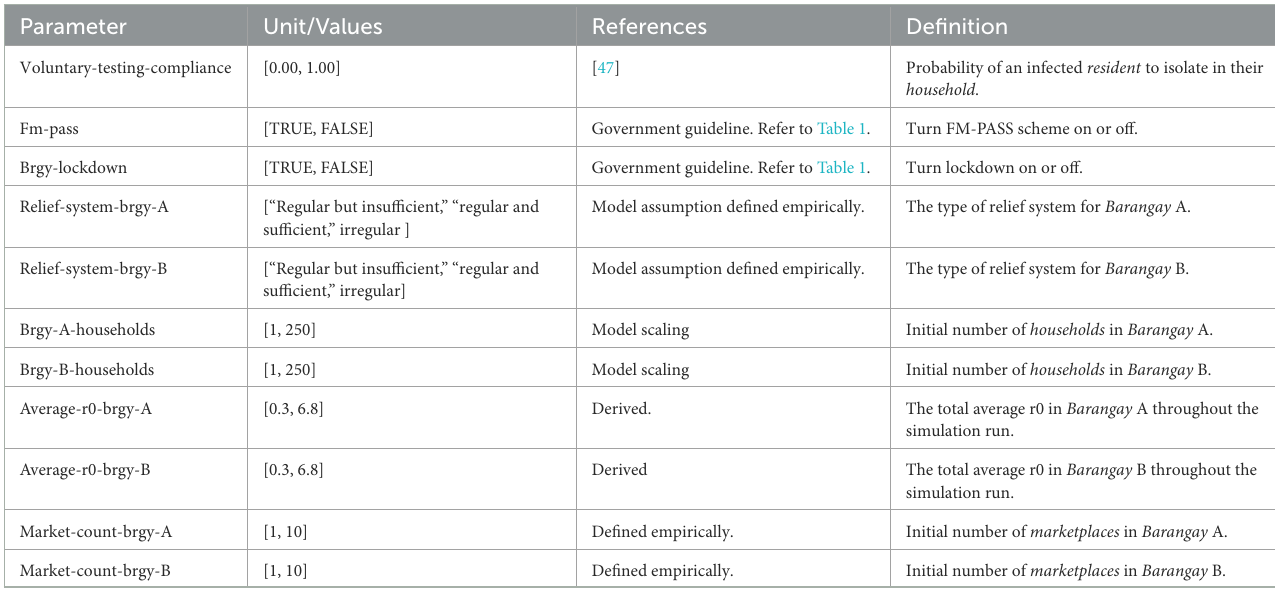
Government guideline. Refer to Table 1. Turn FM-PASS scheme on or off.